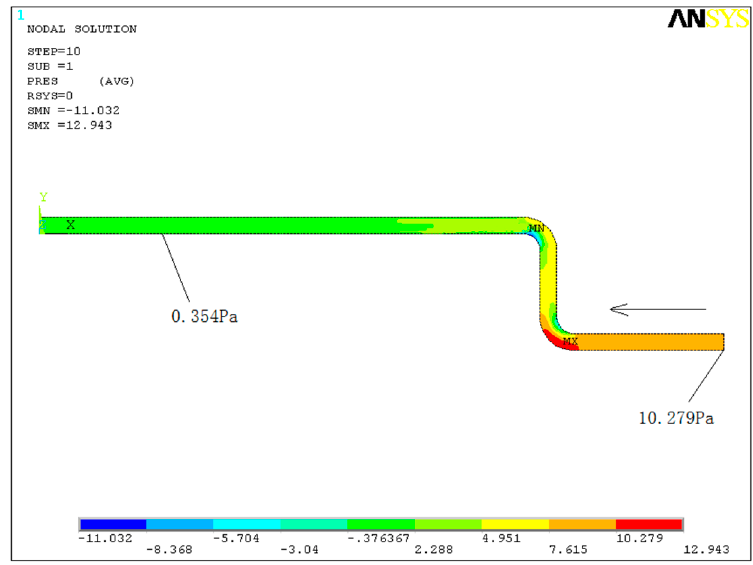
Figure 7. Pressure distribution in the numerical simulation.